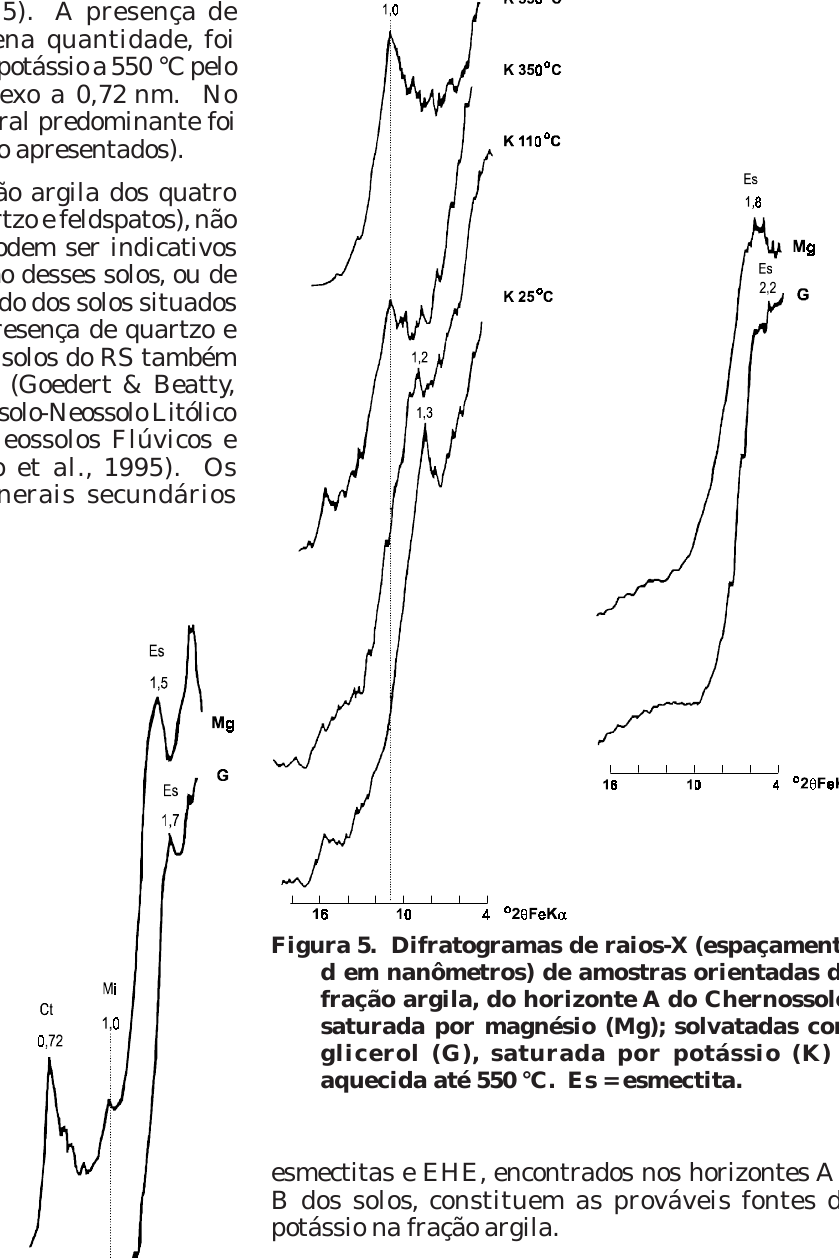
Figura 5. Difratogramas de raios-X (espaçamento d em nanômetros) de amostras orientadas da fração argila, do horizonte A do Chernossolo, saturada por magnésio (Mg); solvatadas com glicerol (G), saturada por potássio (K) e aquecida até 550 °C. Es =